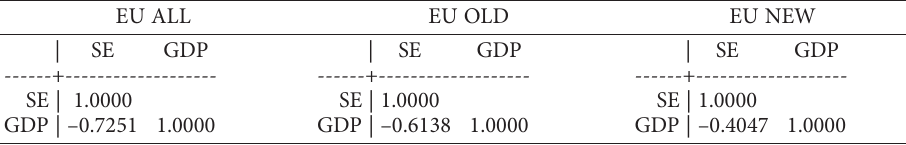
Table 9. Correlation Matrix between SE and GDP EU ALL EU OLD EU NEW | SE